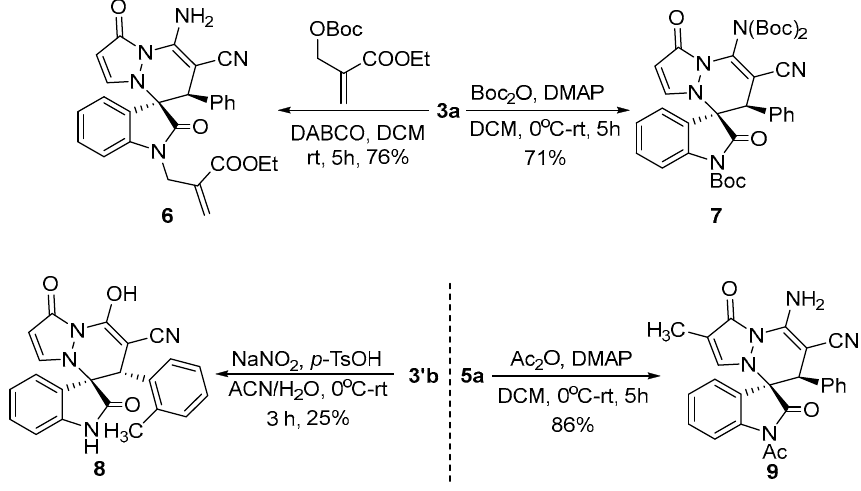
Scheme 2. Transformation of the dicyclic spiropyridazine oxoindole products.